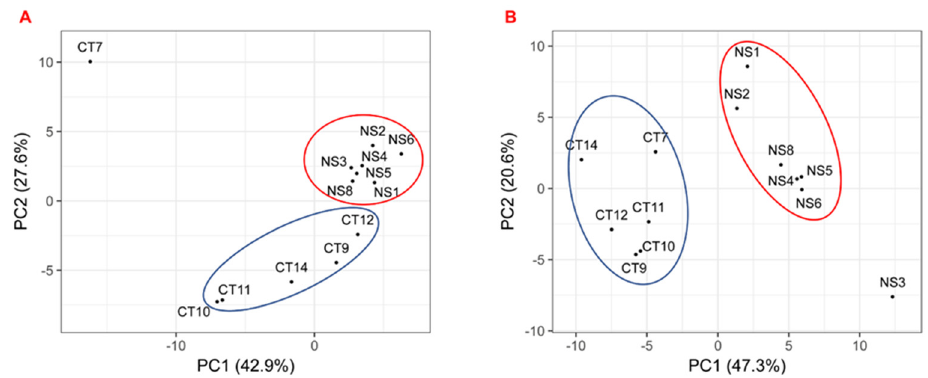
Figure 2. Principal component analysis (PCA) of all 13 strains ( A ) after 24 h incubation; ( B ) after 48 h incubation. The PCA plots, generated by the normalized OD values, represent isolated strains characterized by the Biolog by two or more axes: PC1 (42.9%) and PC2 (27.6%) after 24 h incubation; PC1 (47.3%) and PC2 (20.6%) after 24 h incubation.